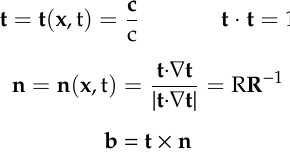
Figure 1. 1D-waveguide with sinusoidal wave propagation (single waveguide element is displayed): Two-way wave equation with two solutions according to the wave velocities + c and – c vs. One-way wave equation with one unique solution acc. to the chosen wave velocity c (here: + c